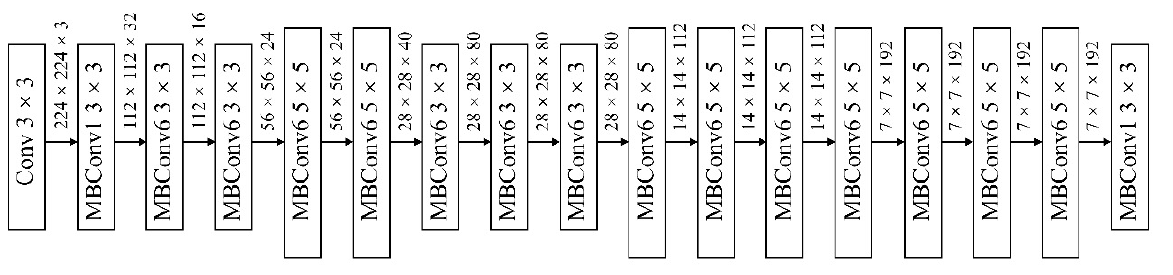
Figure 6. Samples of RGB image, thermal image, MSX image and MSX image with transparency.